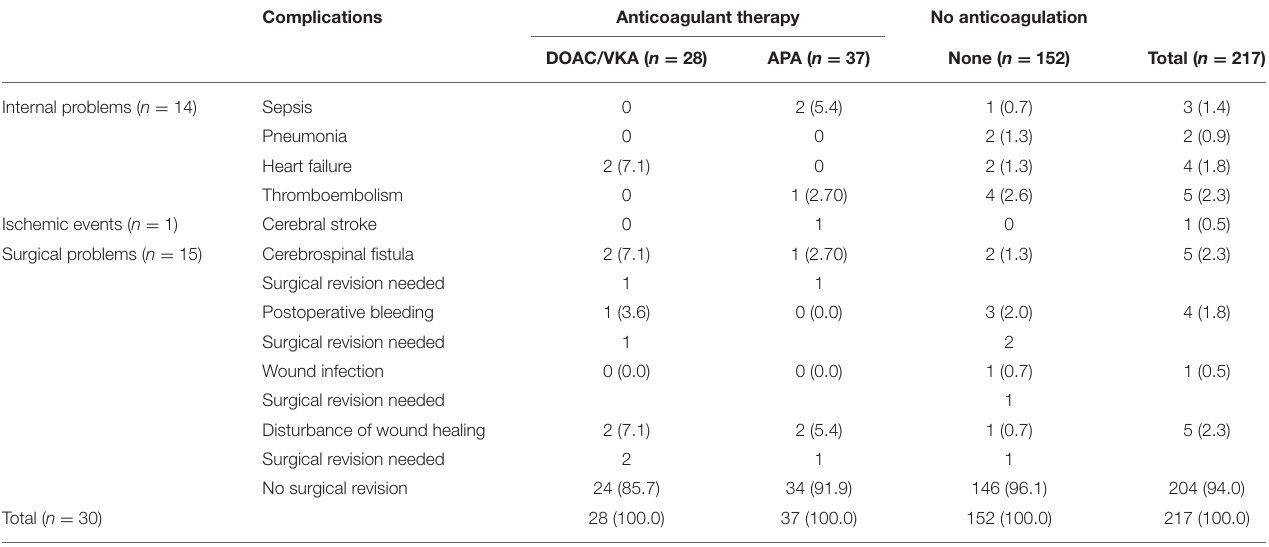
TABLE 3 | Complications after spinal surgery.